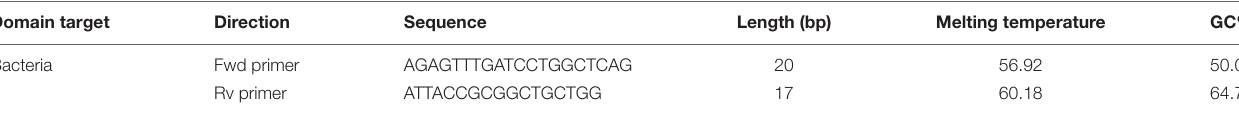
FIGURE 1 | Summary of treatments in the current study. TABLE 1 | Primer sequences used for the taxonomic community analysis in this